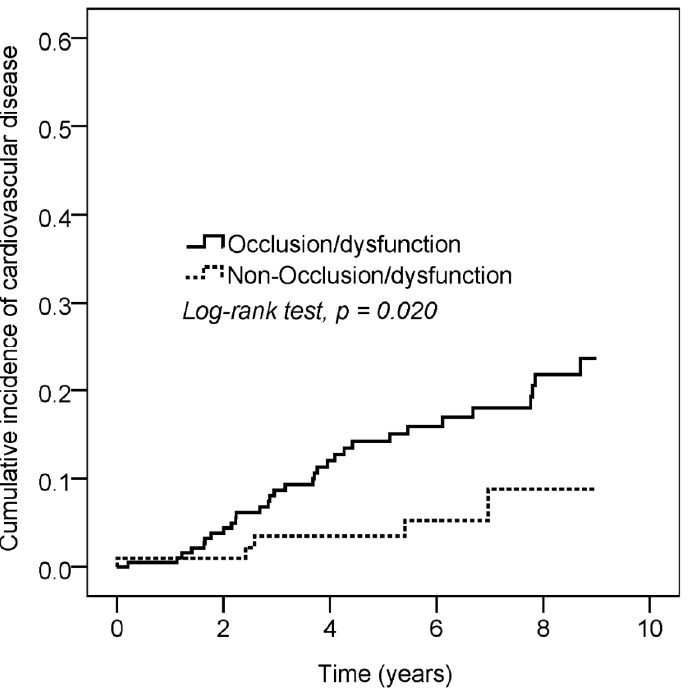
Figure 2. The Kaplan–Meier analysis revealed that the cumulative incidence of cardiovascular disease was higher in the permanent VA dysfunction group than in the comparison group ( p = 0.020). 3.3. Risk of Cardiovascular Disease among Patients with and without Vascular Access Occlusion and Subgroup Specific Characteristics We performed subgroup analysis between the vascular access occlusion group and the non-occlusion group. An increased risk of CVD was statistically observed in the oc- clusion group for patients aged 20-65 years (4.37-fold). An increased risk of CVD was also observed in patients without warfarin (2.74-fold) and statin (3.54-fold) administration in the occlusion group (Table 3). Table 3. Subgroup analysis of Cox proportional hazard model. Occlusion/Dysfunction